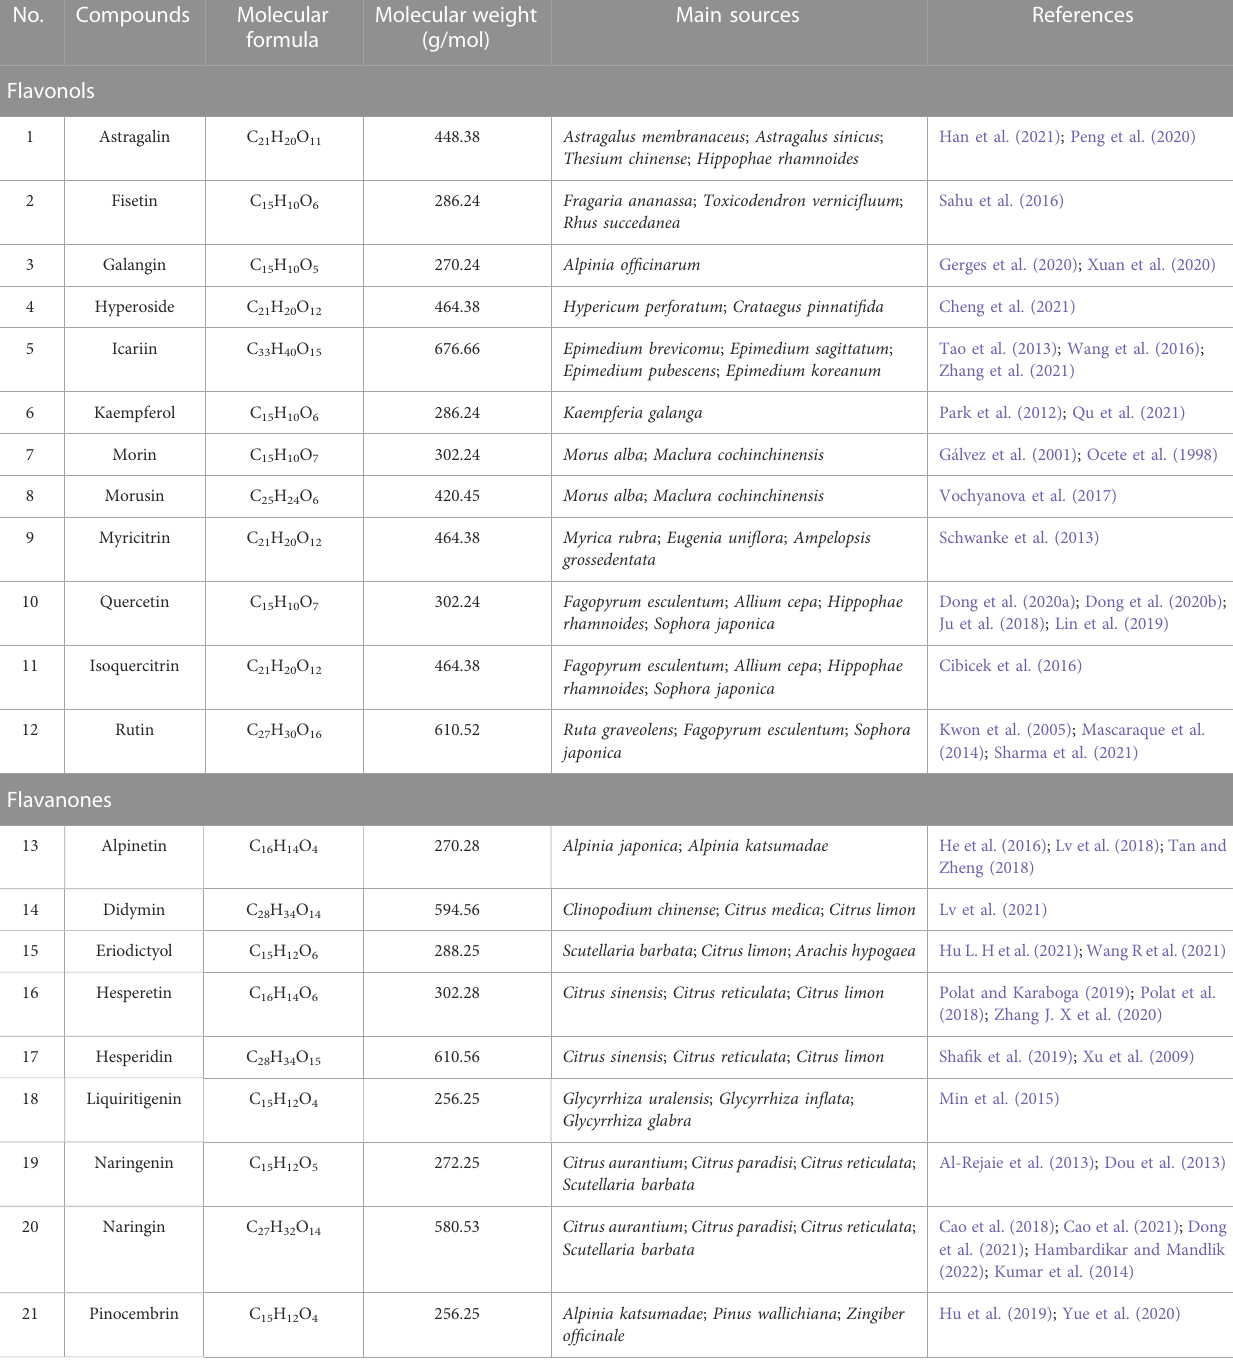
TABLE 1 Natural fl avonols and fl avanones extracted from edible and medicinal plants.